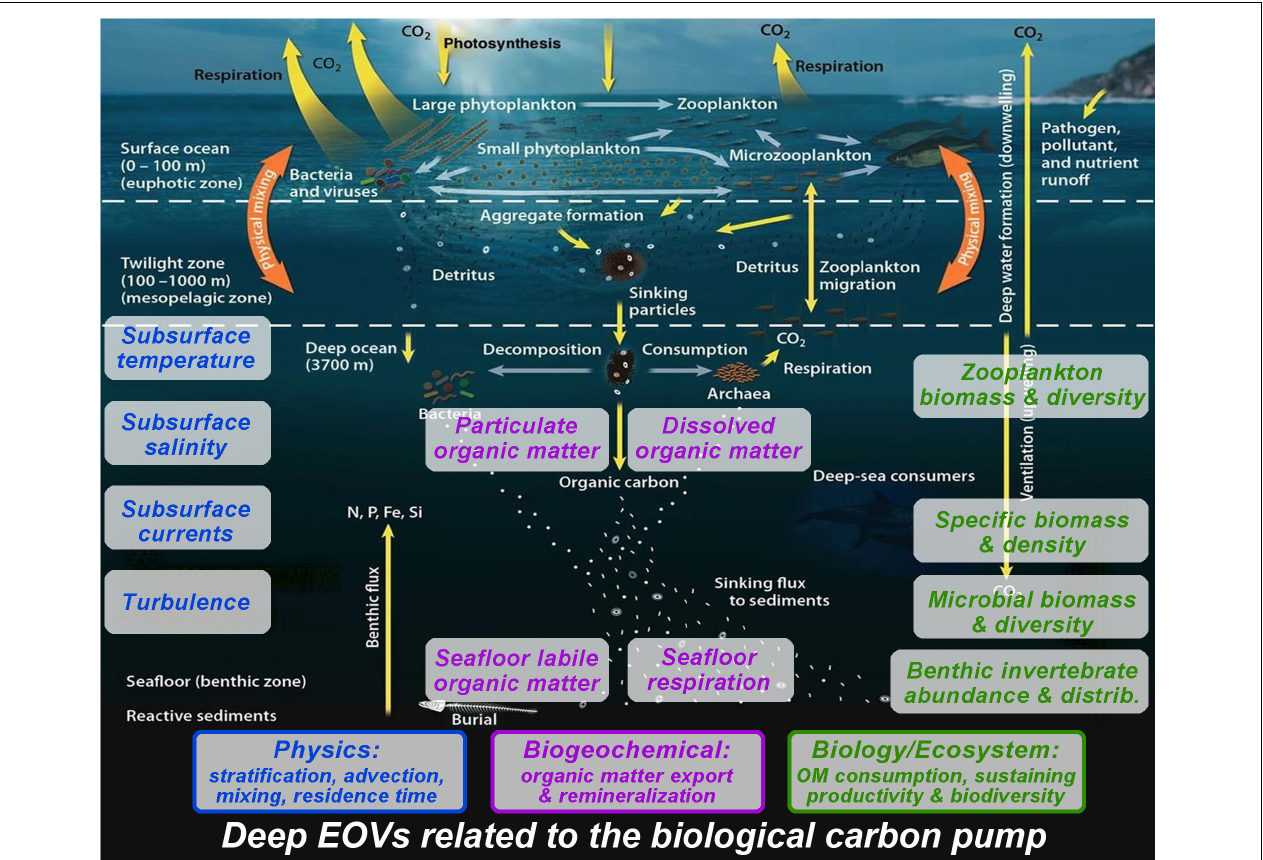
FIGURE 3 | Multidisciplinary observations throughout the water column are necessary to fully address the biological pump. Information that can be derived from EOVs: Physics: stratification affects particle sinking; understanding the origin of the particles and the residence time of the DIC from particle remineralization in the deep ocean requires measurement of advection and mixing. Biogeochemistry: export/mixing down of particulate and dissolved organic matter from the surface layer determines labile organic matter arriving at the seafloor, which is either respired by seafloor biota or stored for longer times in the sediment. Biology and ecosystems: zooplankton and microorganisms break down and remineralize sinking particles in the water column. Exported organic matter feeds all water column and benthic biota (zooplankton, benthic invertebrates, microbes) sustaining their biomass, density, and biodiversity. Background Image: U.S. DOE. 2008. Carbon Cycling and Biosequestration: Report from the March 2008 Workshop, DOE/SC-108, U.S. Department of Energy Office of Science, https://genomicscience.energy.gov/